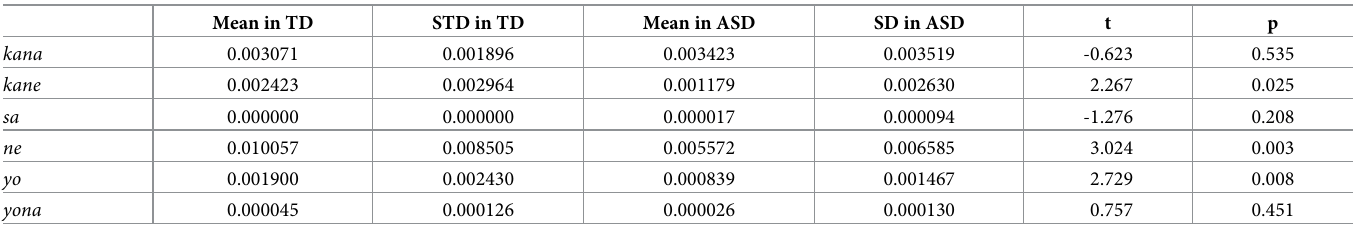
Table 5. Results of Welch’s t-test.